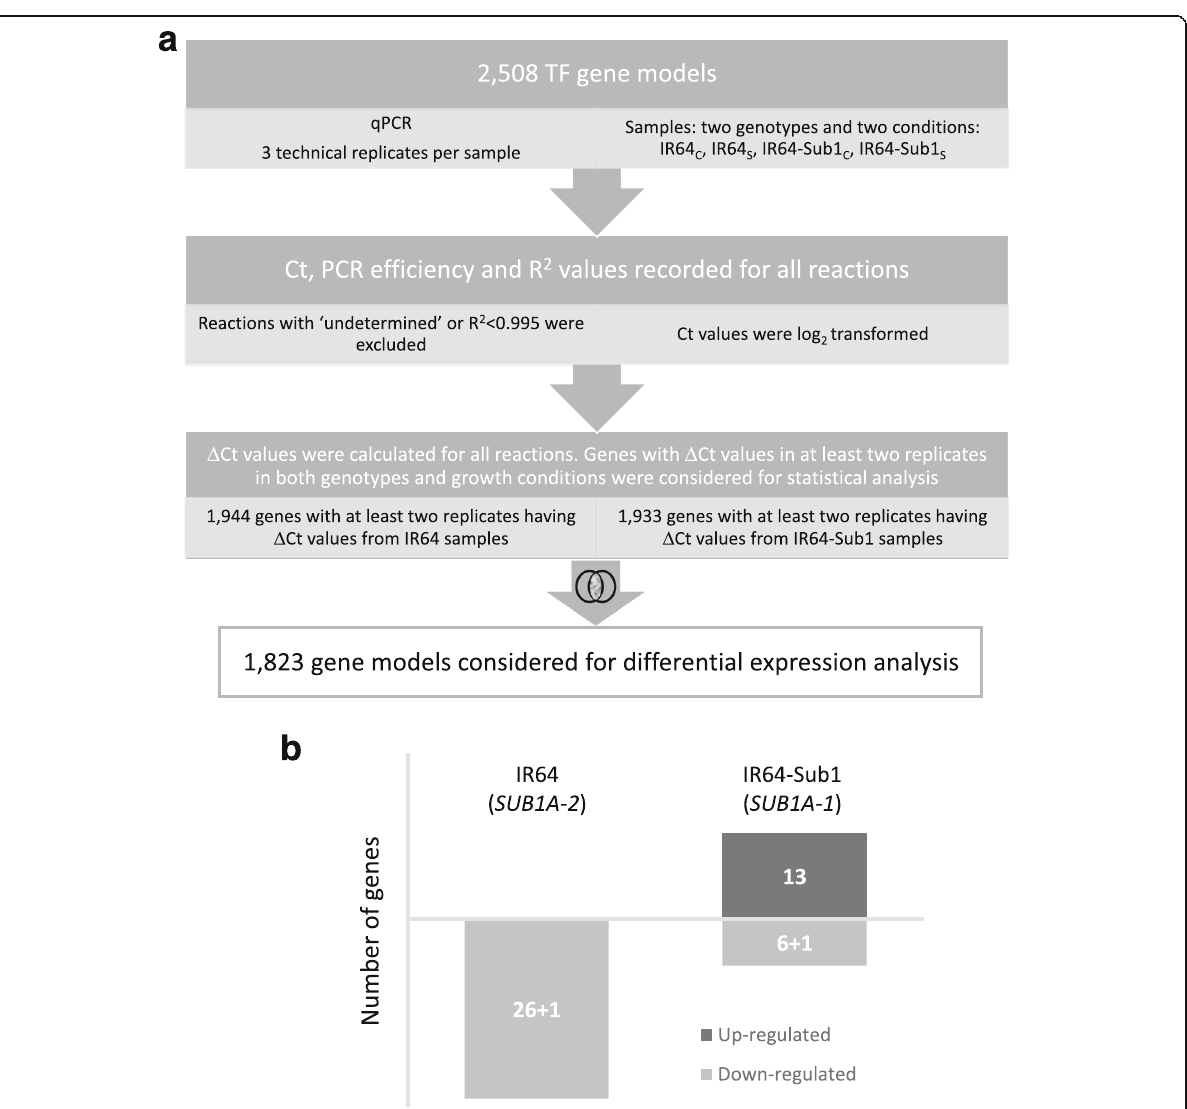
Fig. 1 Identification of differentially expressed transcription factor genes. a Overview of the data processing and selection of genes as input for the statistical analysis of differential gene expression using LIMMA. b Differentially expressed transcription factor genes under submergence stress in IR64 and IR64-Sub1. +1 indicates the common TF gene (MYB), which is submergence-responsive in both